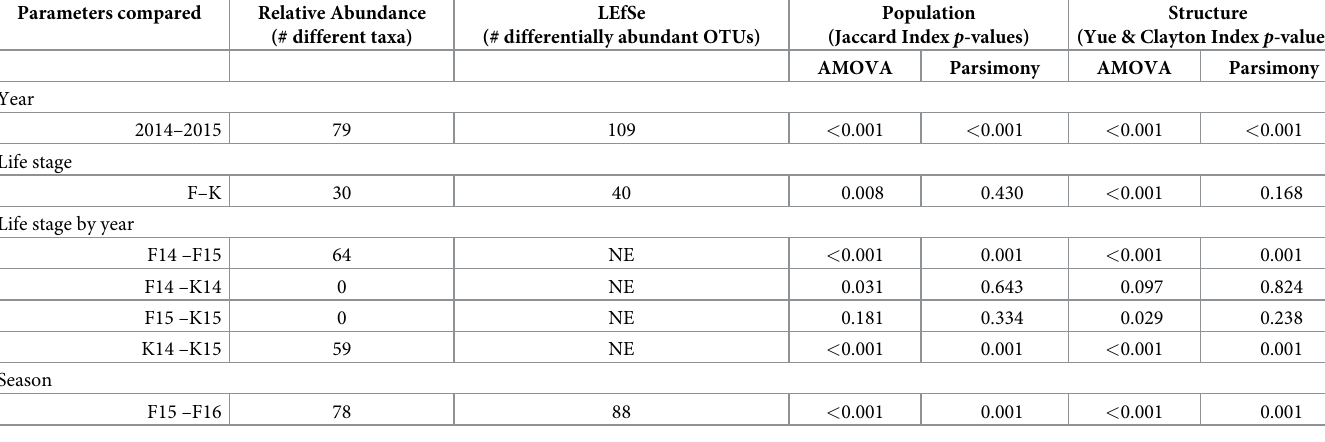
Table 6. Summary of differences in taxa, LEfSE analysis, and beta diversity indices between all comparison groups of the fecal microbiota of mink. Parameters compared Relative Abundance (# different